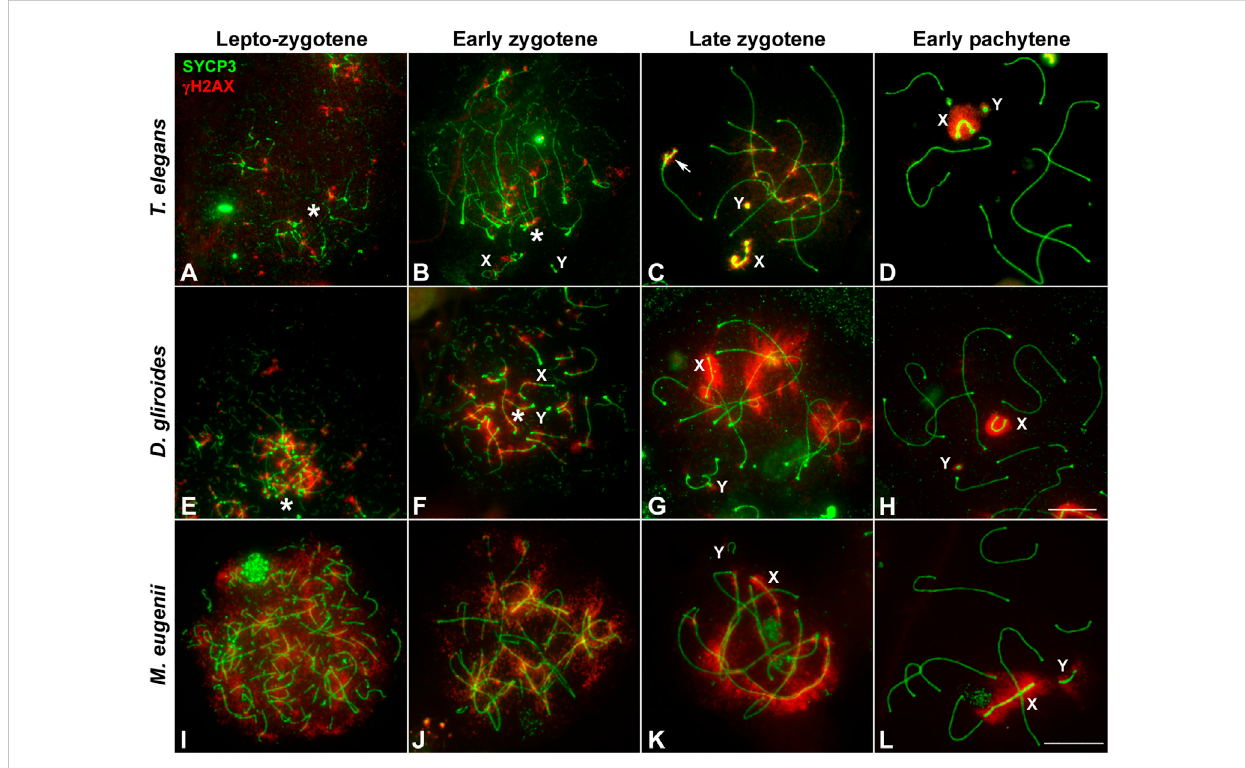
FIGURE 4 Localization of DNA damage-related proteins. Spread spermatocytes labeled with antibodies against SYCP3 (green) and γ H2AX (red). (A – D) . Thylamys elegans. γ H2AX is observed as small foci at the leptotene-zygotene transition (A) and early zygotene (B) , associated to the synapsing chromosomal ends polarized to the bouquet (asterisks). A more intense γ H2AX labeling is observed at late zygotene (C) associated to the AEs of unsynapsedautosomalregionsandsexchromosomes(X,Y).Theproximalendofchromosome6alsoremainsunsynapsed(arrow).Atpachytene (D) γ H2AX is only observed on the chromatin of sex chromosomes. (E – H) . D. gliroides . The pattern of γ H2AX is almost identical to the one described for Thylamys elegans , except for a more intense labeling of γ H2AX in the unsynapsed regions of chromosomes at zygotene. ( I – L ) Macropus eugenii . At the leptotene to zygotene transition (I) γ H2AX is spread in the whole nucleus. As zygotene proceeds (J,K) γ H2AX labeling is reduced in the nucleus and concentrates around the AEs of unsynapsed autosomes and the X chromosome, but not on the Y chromosome. Both sex chromosomes exhibit signal of the antibody at pachytene ( L ). Bars in A-H and I – L: 10 μ